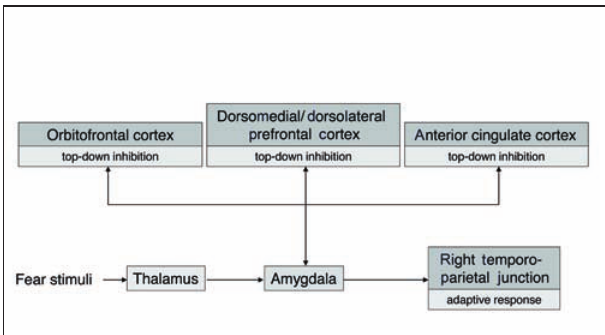
Fig. 1. Primary brain areas involved in top-down inhibition after fear